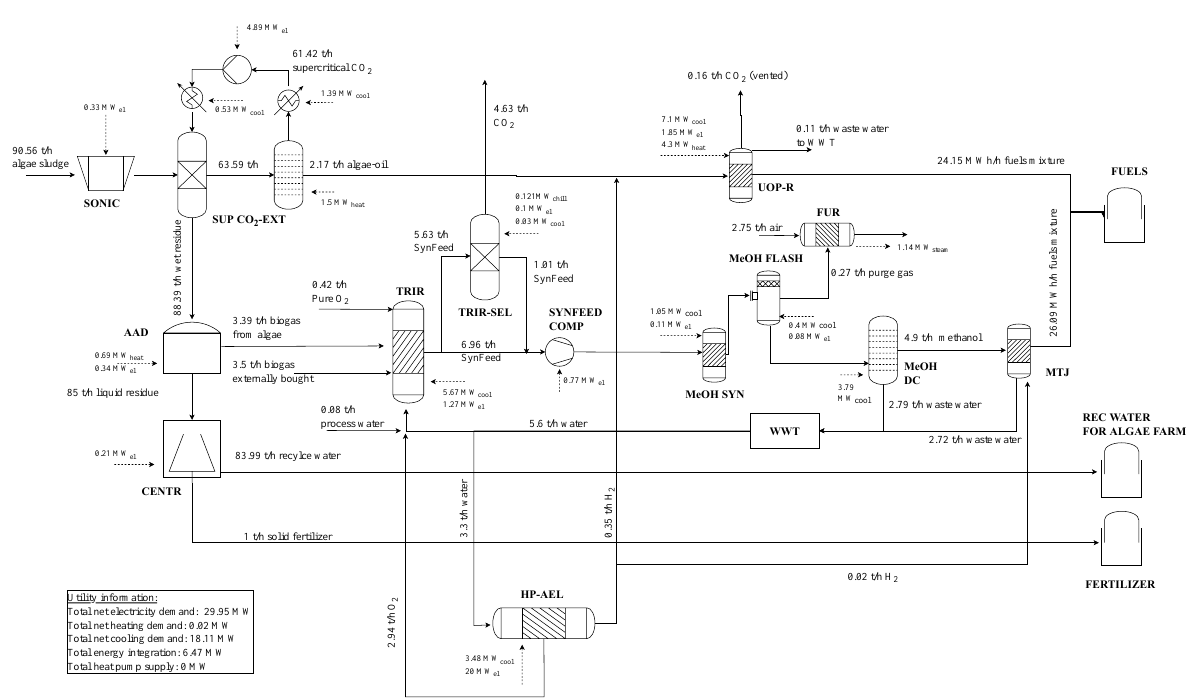
Figure 13. Process flow diagram of NPC-optimized renewable refinery base case. Error! Reference source not found. Table 9 presents the cost breakdown of the NPC. Heat integration reduces the external heat demand from ca. 6.49 MW to 0.02 MW.